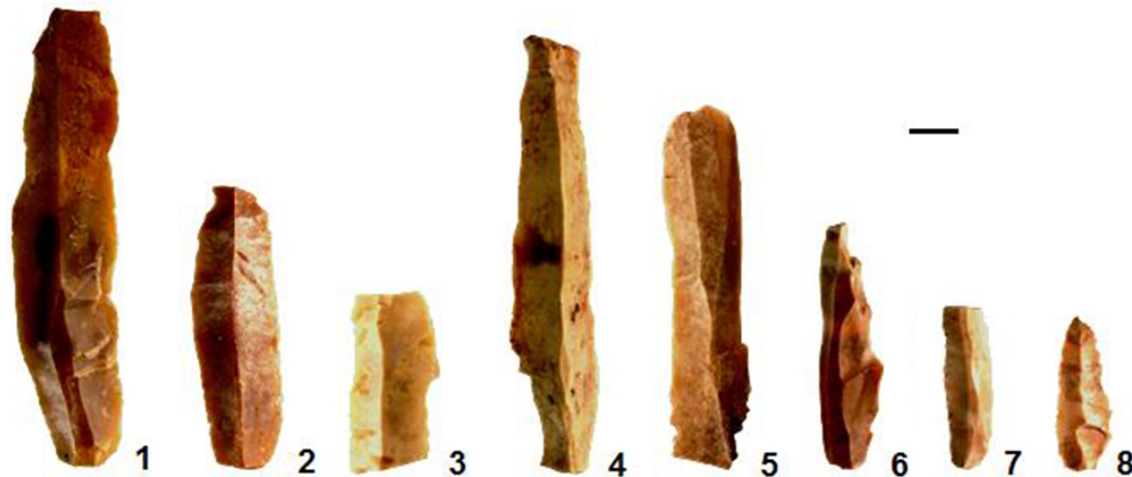
Figura 7. Lâminas e lamelas do concheiro do Meu Jardim. 1-3: lâminas da Sondagem 3, Fase III; 4-5: lamelas da Sondagem 3, Fase II; 8: lamela da Sondagem 1, Fase III; 7: lamela da Sondagem 3, Fase II; 8: lamela da Sondagem 3, Fase IV. (barra = 1 cm). Figure 7. Blades and bladelets from the shell-midden of Meu Jardim. 1-3: blades from Test 3, Phase III; 4-5: bladelets from Test 3, Phase II; 8: bladelet from Test 1, Phase III; 7: bladelet from Test 3, Phase II; 8: bladelet from Test 3, Phase IV. (bar = 1